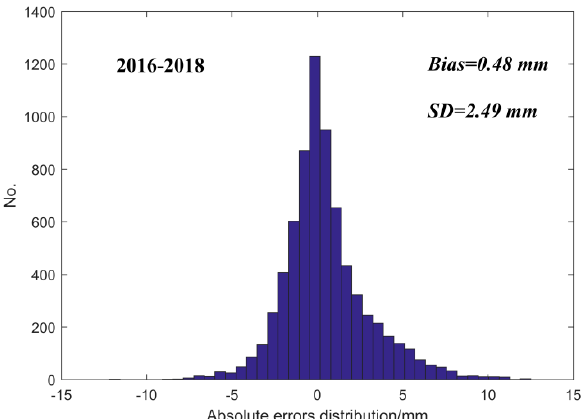
Figure 11. Error distributions of the fusion product in 2016–2018.